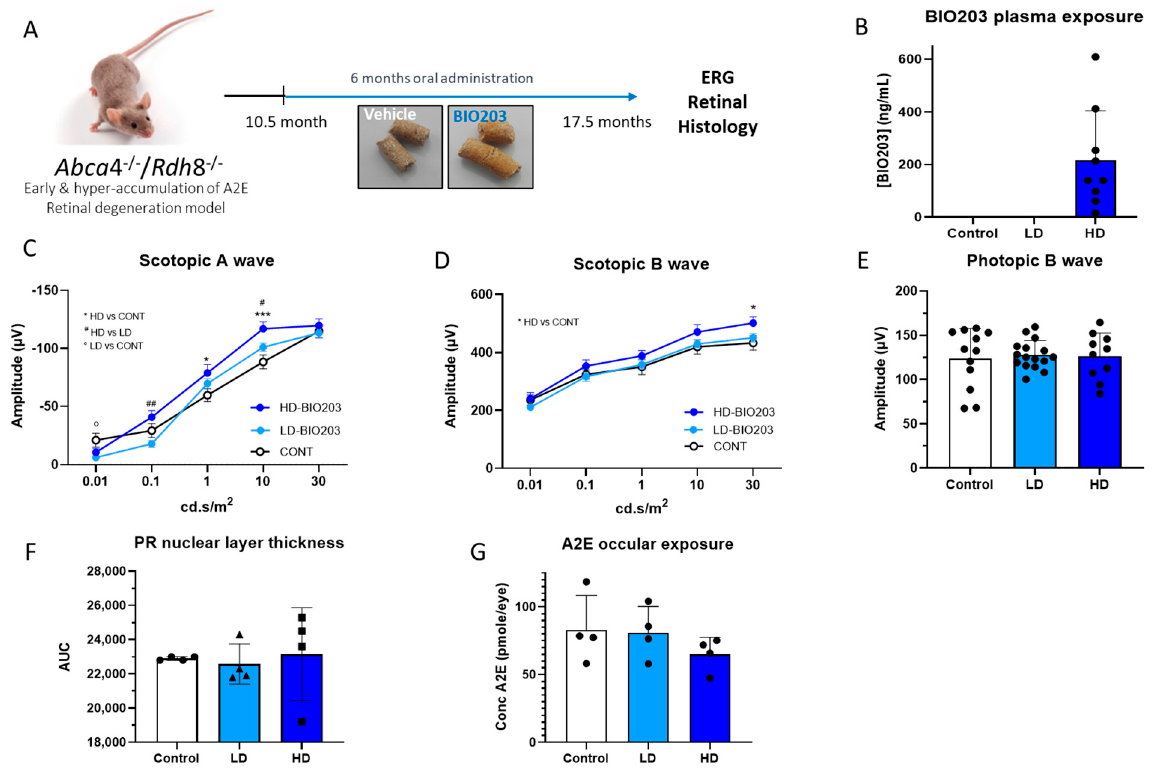
( C ) Graph showing the number of photoreceptor layers measured along the retina, each 200 µ m from the optic nerve. ( D ) Histograms showing the area under the curve (AUC) calculated from the photoreceptor layer quantification and used to perform statistical analyses. The doses of PBN (used as a positive control), BIO203, and norbixin are expressed in mg/kg. Bars represent mean ± s.e.m. with n = 10 animals per group (20 eyes analyzed). *** p < 0.001, **** p < 0.0001 compared to the vehicle group (One-way ANOVA, Dunnett’s post-test).